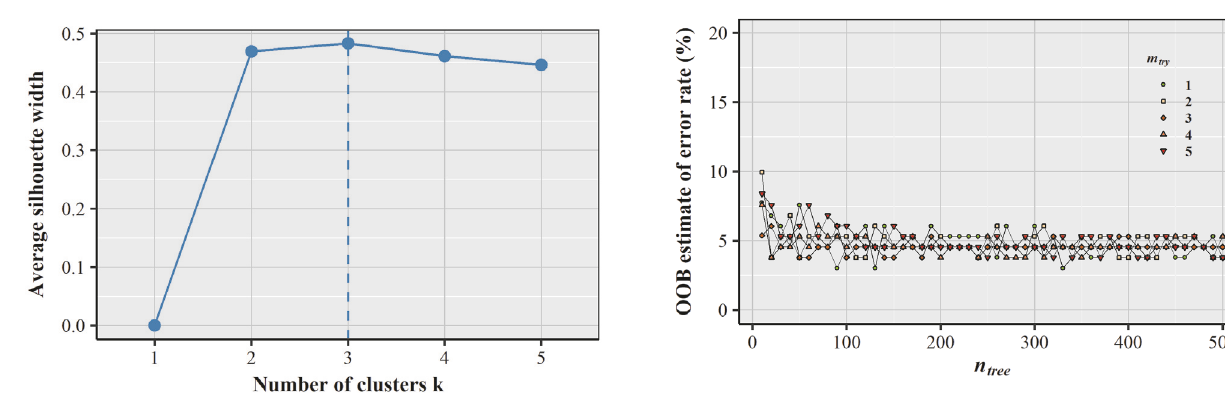
Figure 5: Influence of the combined parameters ( n 𝑡𝑟𝑒𝑒 and m 𝑡𝑟𝑦 ) on OOB